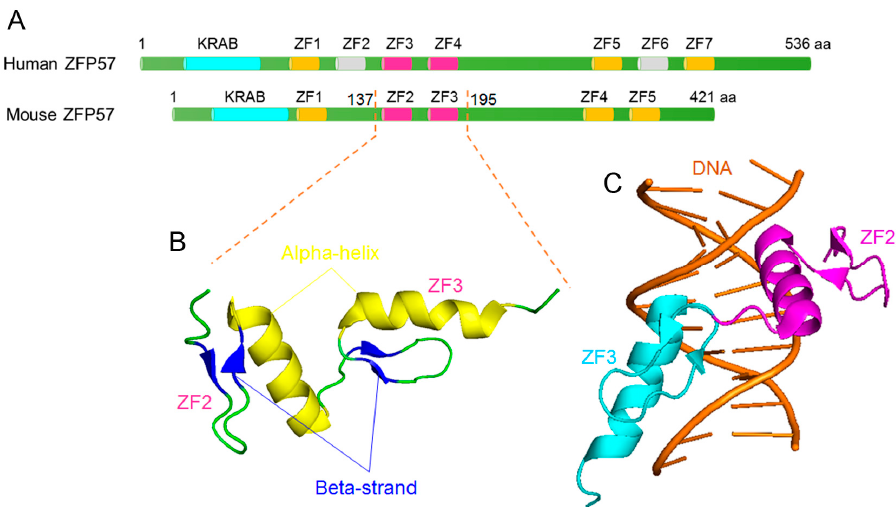
Figure 5. Structural characterization of zinc finger protein 57 (ZFP57) proteins. ( A ) Schematic diagrams are shown for human and mouse ZFP57 proteins. Same colours indicate the conserved domains between human and mouse ZFP57. Both human ZFP57 and mouse ZFP57 contain a highly conserved Kruppel-associated box (KRAB) (in cyan) at the N-terminus. The full-length human ZFP57 is predicted to have seven zinc finger (ZF) domains, whereas mouse ZFP57 only has five ZF domains. ZF3 and ZF4 of human ZFP57 are highly homologous to ZF2 and ZF3 of mouse ZFP57. ( B ) X-ray crystal structure of the DNA-binding domain of mouse ZFP57 (residues 137-195; PDB ID: 4GZN). Here, α -helices and β -strand are coloured in yellow and blue , respectively. ( C ) X-ray crystal structure of the DNA-binding domain of mouse ZFP57 (residues 137-195; PDB ID: 4GZN) in a complex with methylated DNA. The ZF2, ZF3 and methylated DNA are coloured in magenta , cyan and orange , respectively.